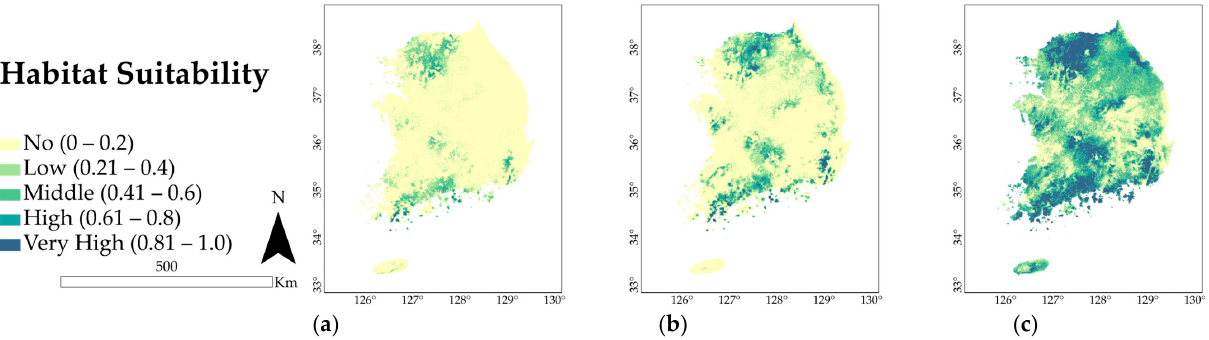
Figure 4. Predicted habitat suitability of Q. acuta in South Korea under future conditions: ( a ) SSP5-8.5 Near future; ( b ) SSP5-8.5 Middle future; ( c ) SSP5-8.5 Far future.